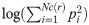
Validating FD algorithm using the Menger sponge phantom, shown in A; B shows corresponding log-log plots for the D2
fractal dimension measure. (A). Menger sponge 5-iteration phantom is a mathematical fractal made by dividing a cube into 27 smaller cubes and removing seven of the cubes, a process repeated for each of the subsequently smaller cubes 5 times (image size 486 x 486 x 486; the dimension of the smallest hole is 2; thus, the size of each hole is: x = 2, y = 2, z = 2). The expected FD of Menger Sponge is 2.726833. The Menger sponge is rendered using Mandelbulber (https://github.com/buddhi1980/mandelbulber2) open-source software. (B). Correlation dimension, D2, measure. In the scatterplot of log(r) versus log(∑i=1Nc(r)pi2), r is the box size and log(∑i=1Nc(r)pi2) is the information for box size r. Note. The initial, pre-determined range of box sizes is r = 2… 243 voxels (in increments of 1 voxel). The linear regression analysis is performed iteratively, and the blue line indicates the linear fit over the entire range of r. The red dotted line indicates the final fit (R2); the slope of this line corresponds to the fractal dimension, D2. The breakpoint separates non-linear data points from the data used in the final regression analysis; ln denotes the natural log. Min r is the new smallest box size and Max r is the new largest box size.